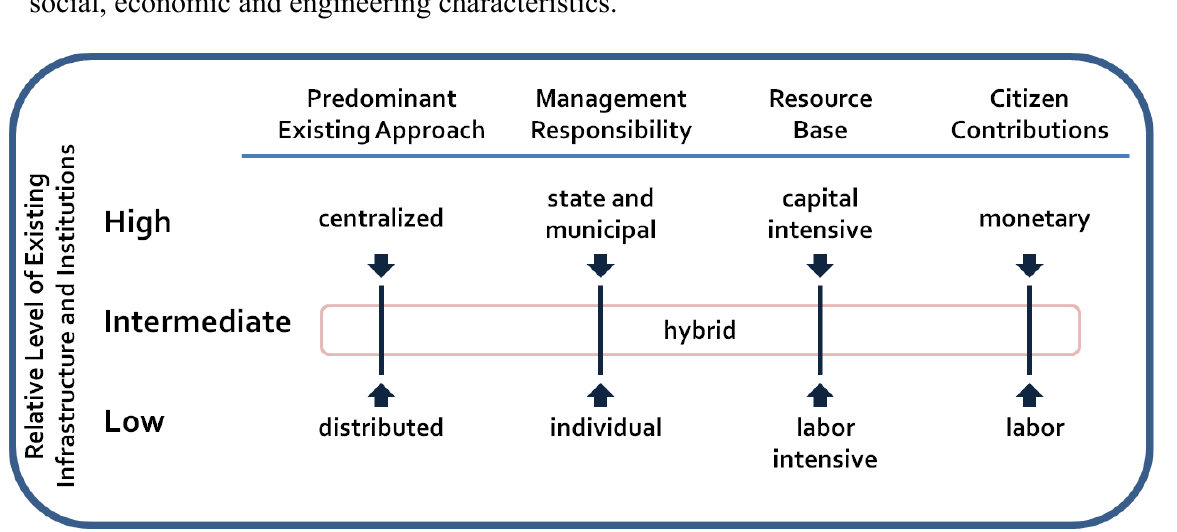
Figure 2. Framework to understand relationships between existing infrastructure and social, economic and engineering